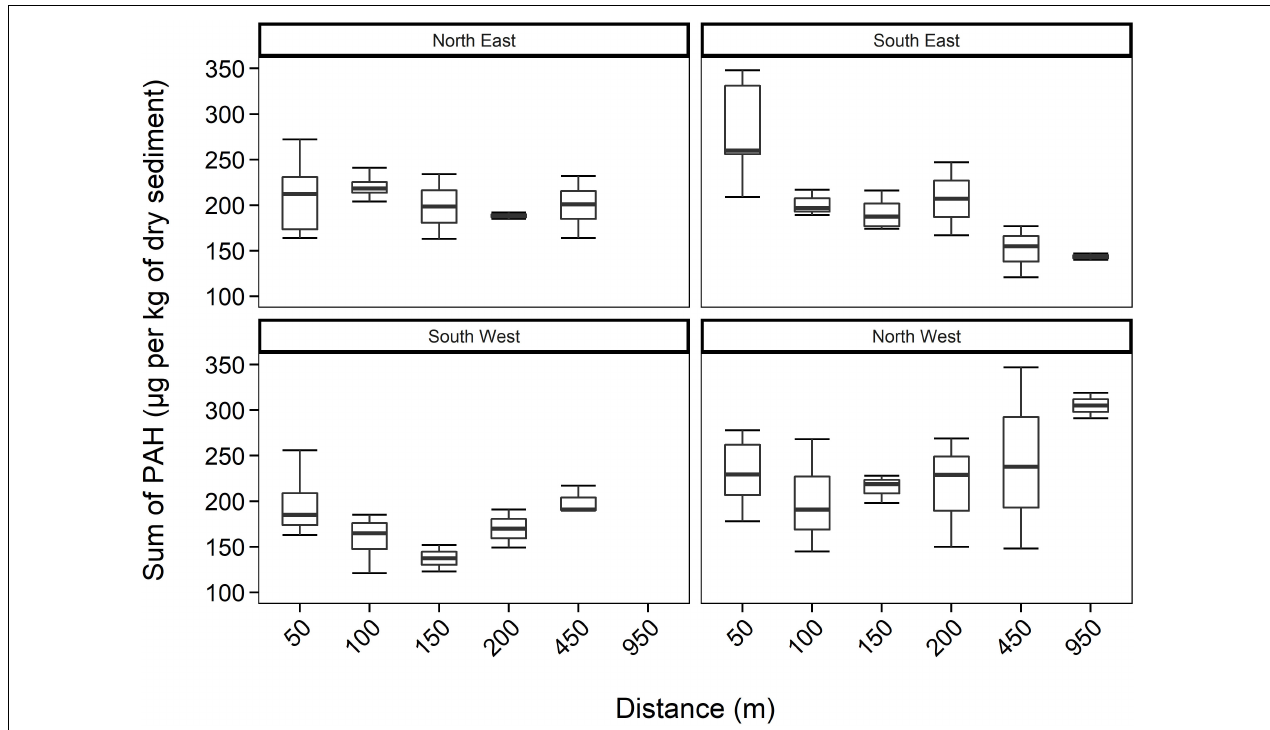
FIGURE 2 | Total PAH concentrations (mean ± SE, n = 2) within sediments, including all depths, over 950 m transects (where those sediments sampled further away act as controls) in four different directions from HMS Royal Oak shipwreck; located in Scapa Flow, Scotland, United Kingdom, November 2019.